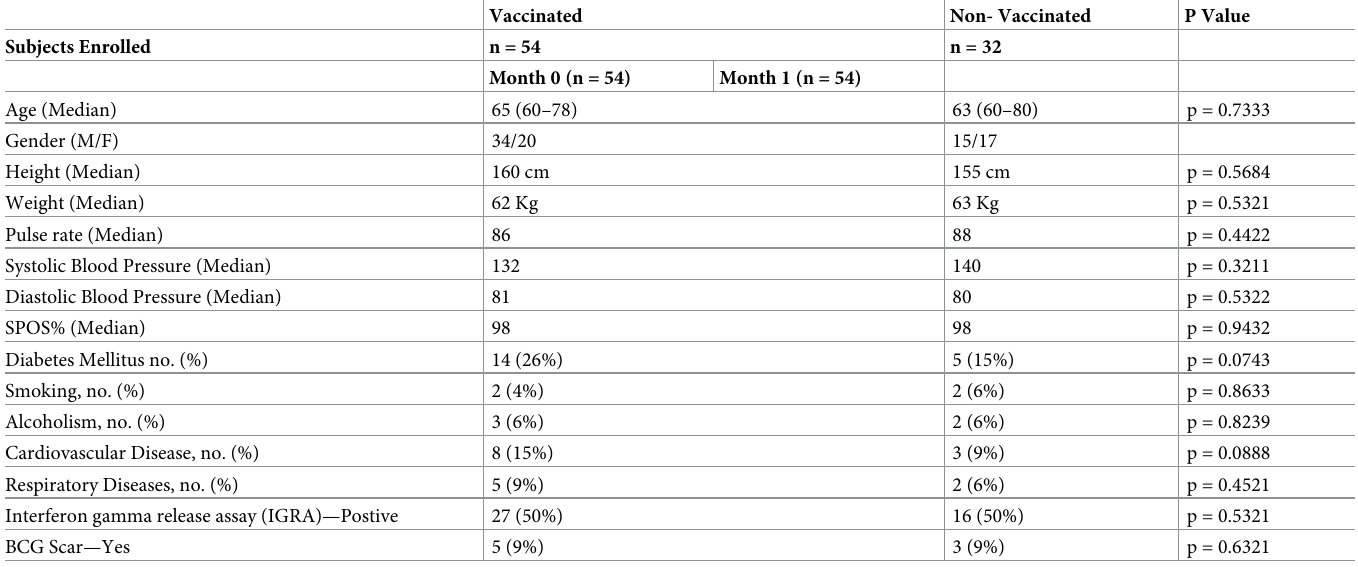
Table 1. Demographics of the study